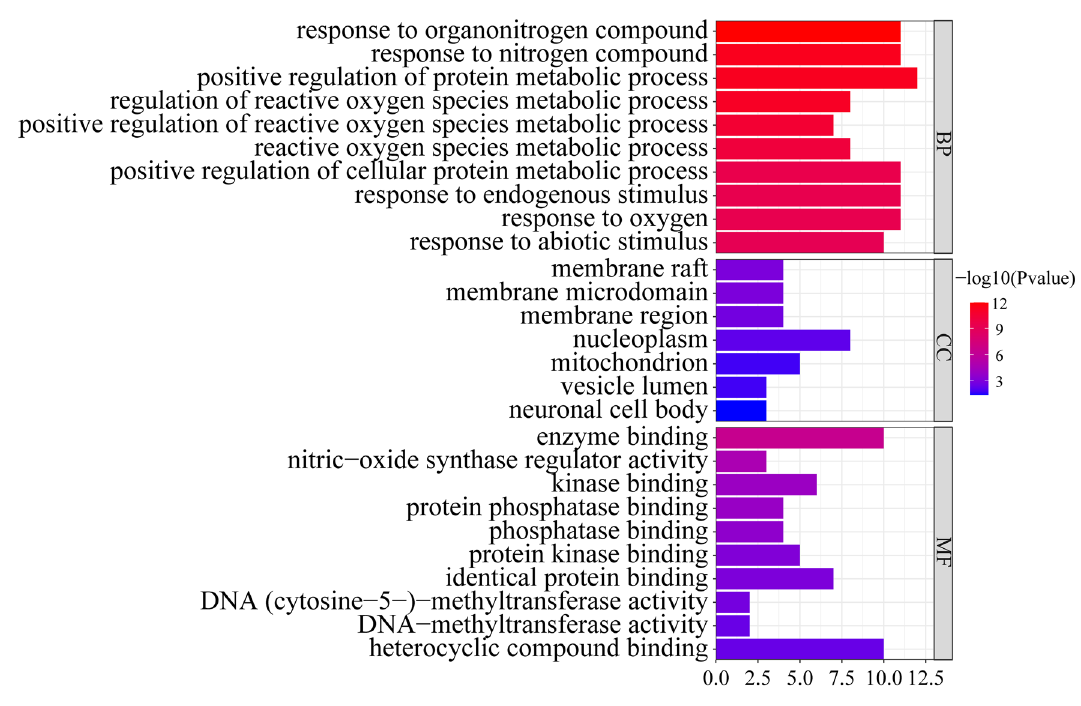
Figure 4. GO enrichment analysis.